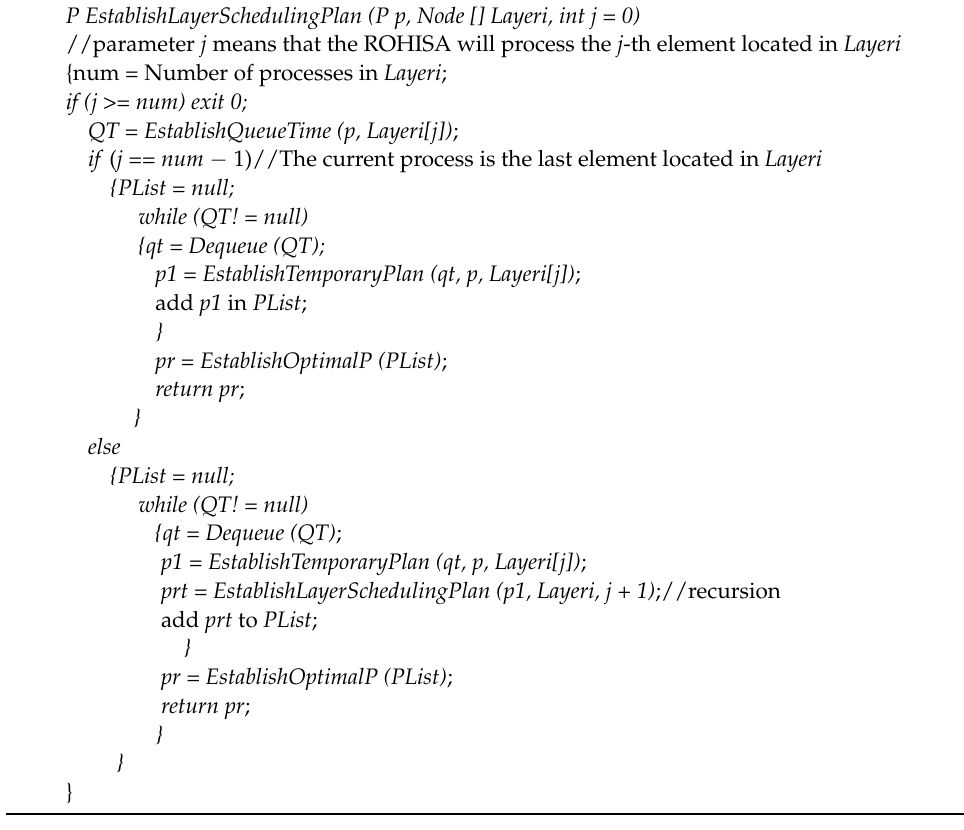
Algorithm 6 EstablishLayerSchedulingPlan.//Establishing SS SLP for the i -th layer P EstablishLayerSchedulingPlan (P p, Node [] Layeri, int j = 0)